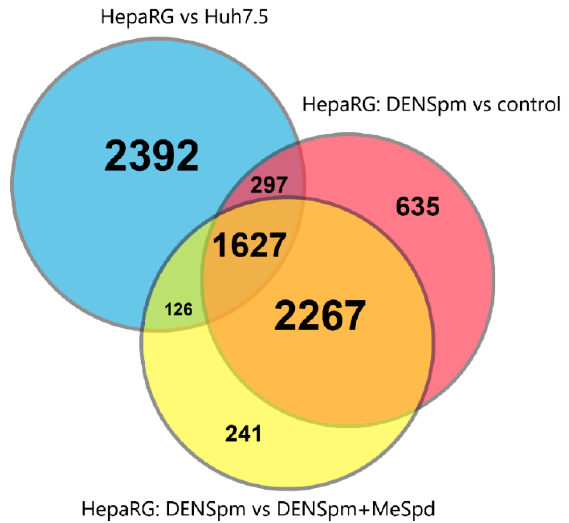
Figure 6. Venn diagram demonstrating the overlaps between the lists of differentially expressed genes for three comparisons.